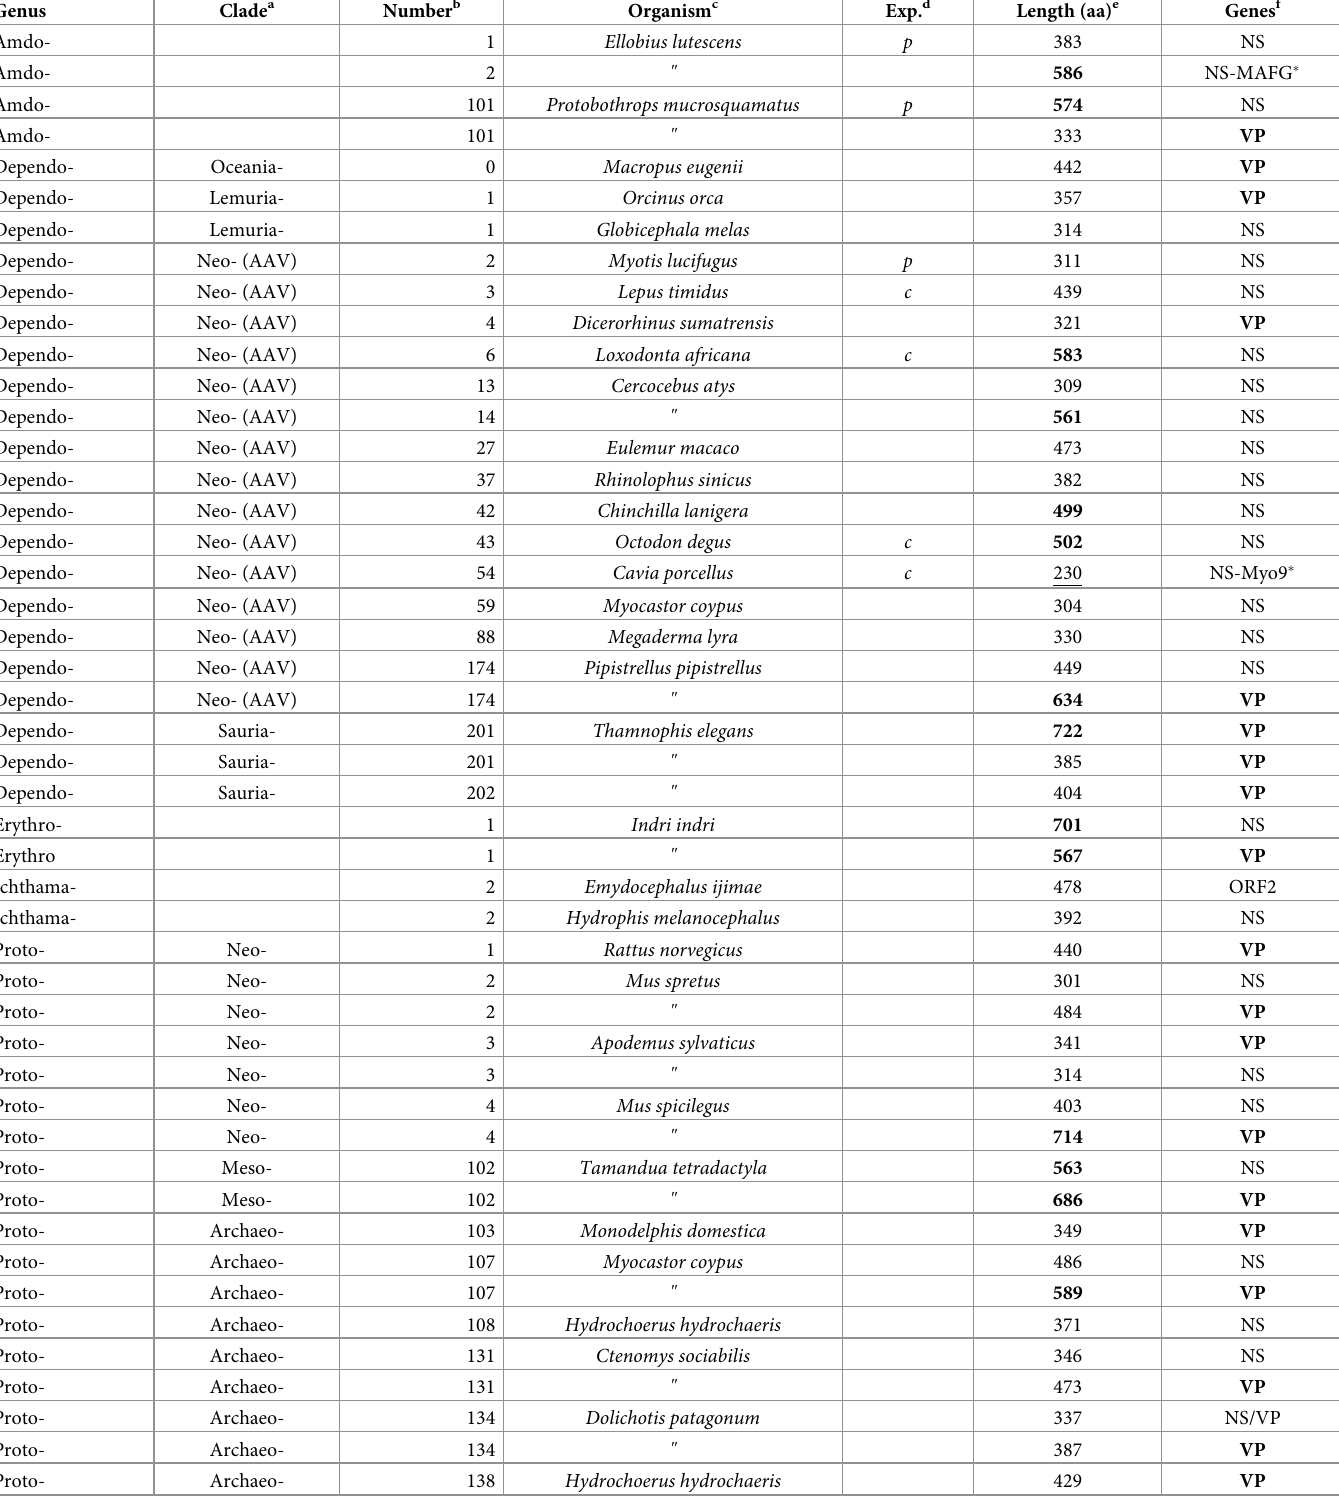
Table 4. Coding capacity and expression of vertebrate